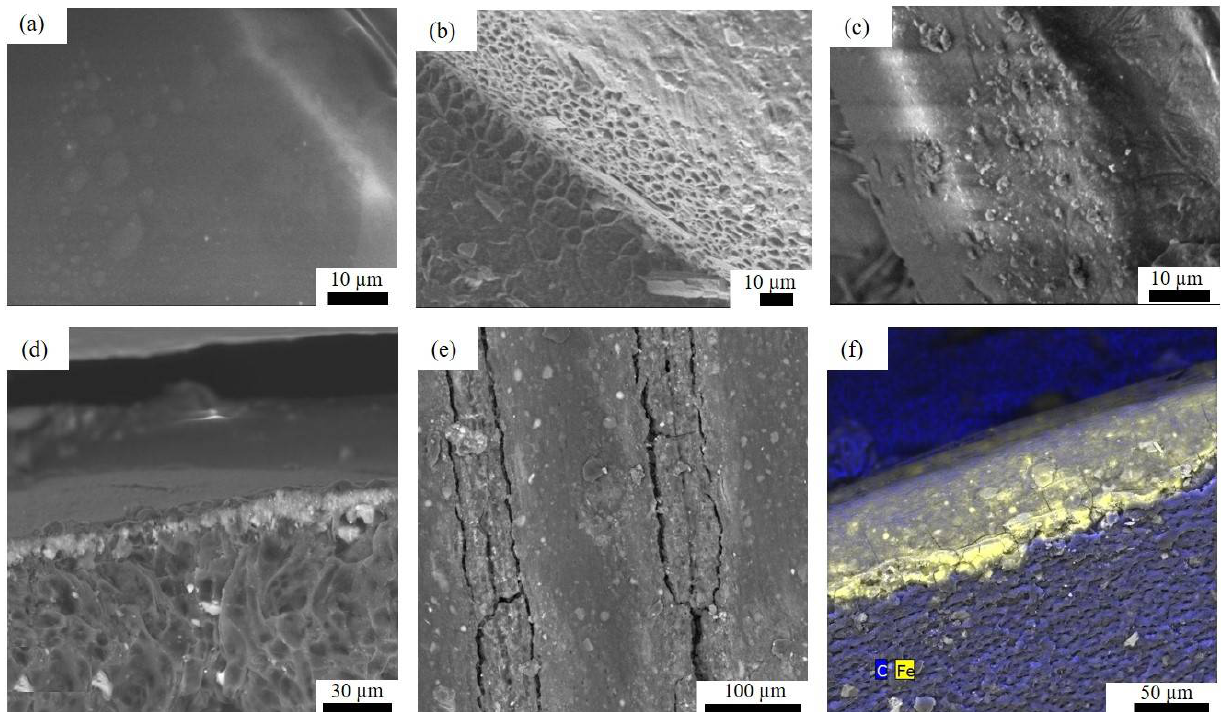
Figure 3. SEM images of a PLA 3D-printed surface ( a ) before, ( b ) after etching process, ( c ) etching process and NPs impregnation, ( d ) cross-section of NPs impregnated surface, ( e ) etching process and Fe impregnation, and ( f ) cross-section of an Fe-impregnated surface.